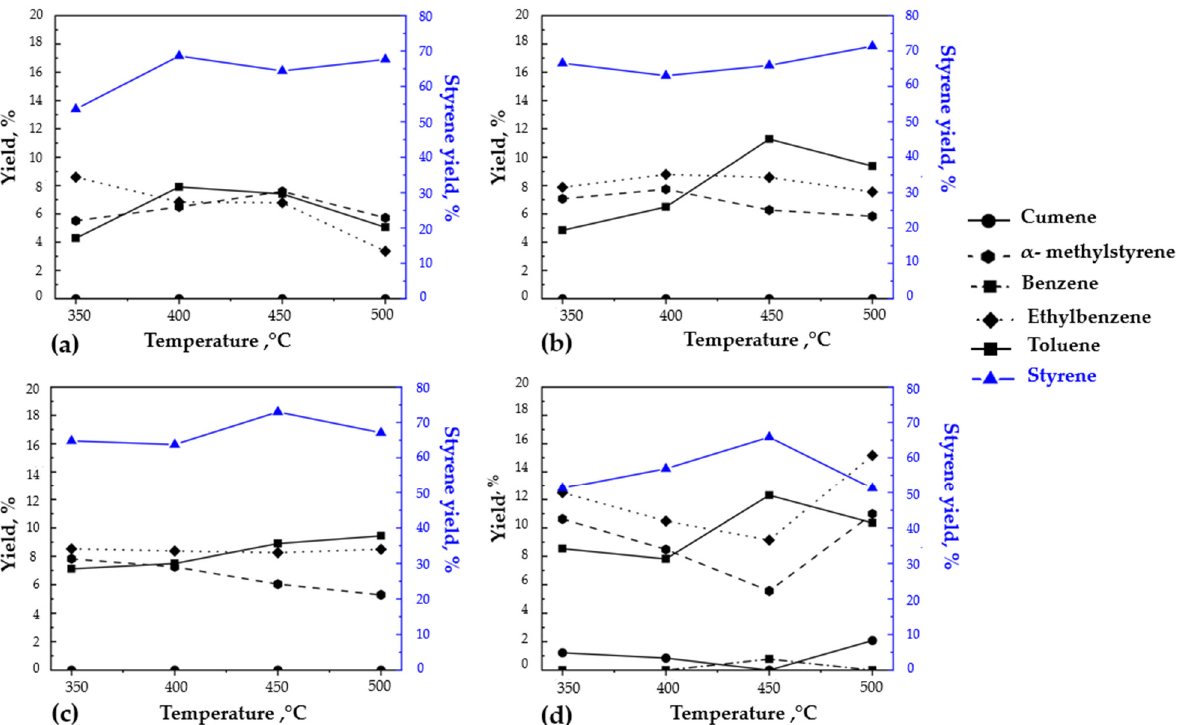
Figure 4. Influence of temperature and heating rate on the obtaining of value-added products. Heat- ing rates: ( a ) 4 °C min − 1 , ( b ) 12 °C min − 1 , ( c ) 25 °C min − 1 , ( d ) 40 °C min − 1 .